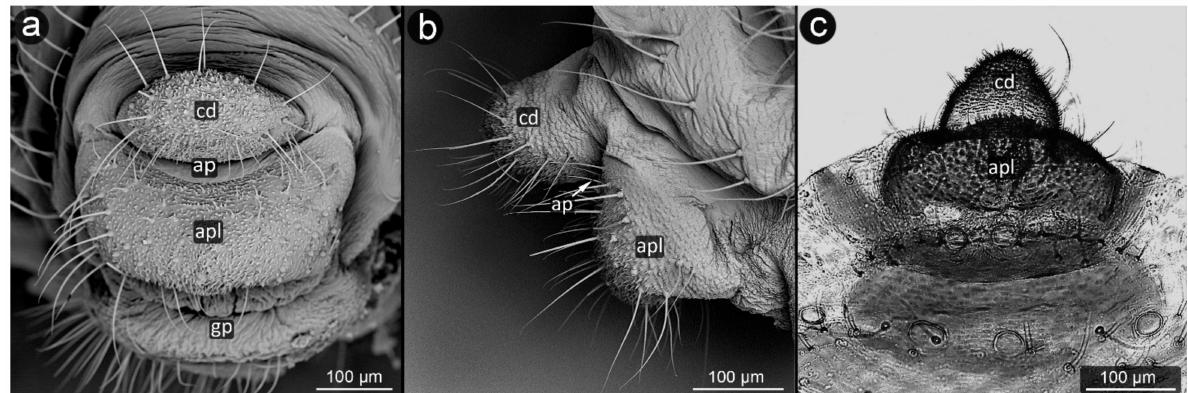
Figure 25. Perianal structure of Dysaphis anthrisci ; ( a )—rear view (SEM), ( b )—lateral view (SEM), ( c )— rear view in light